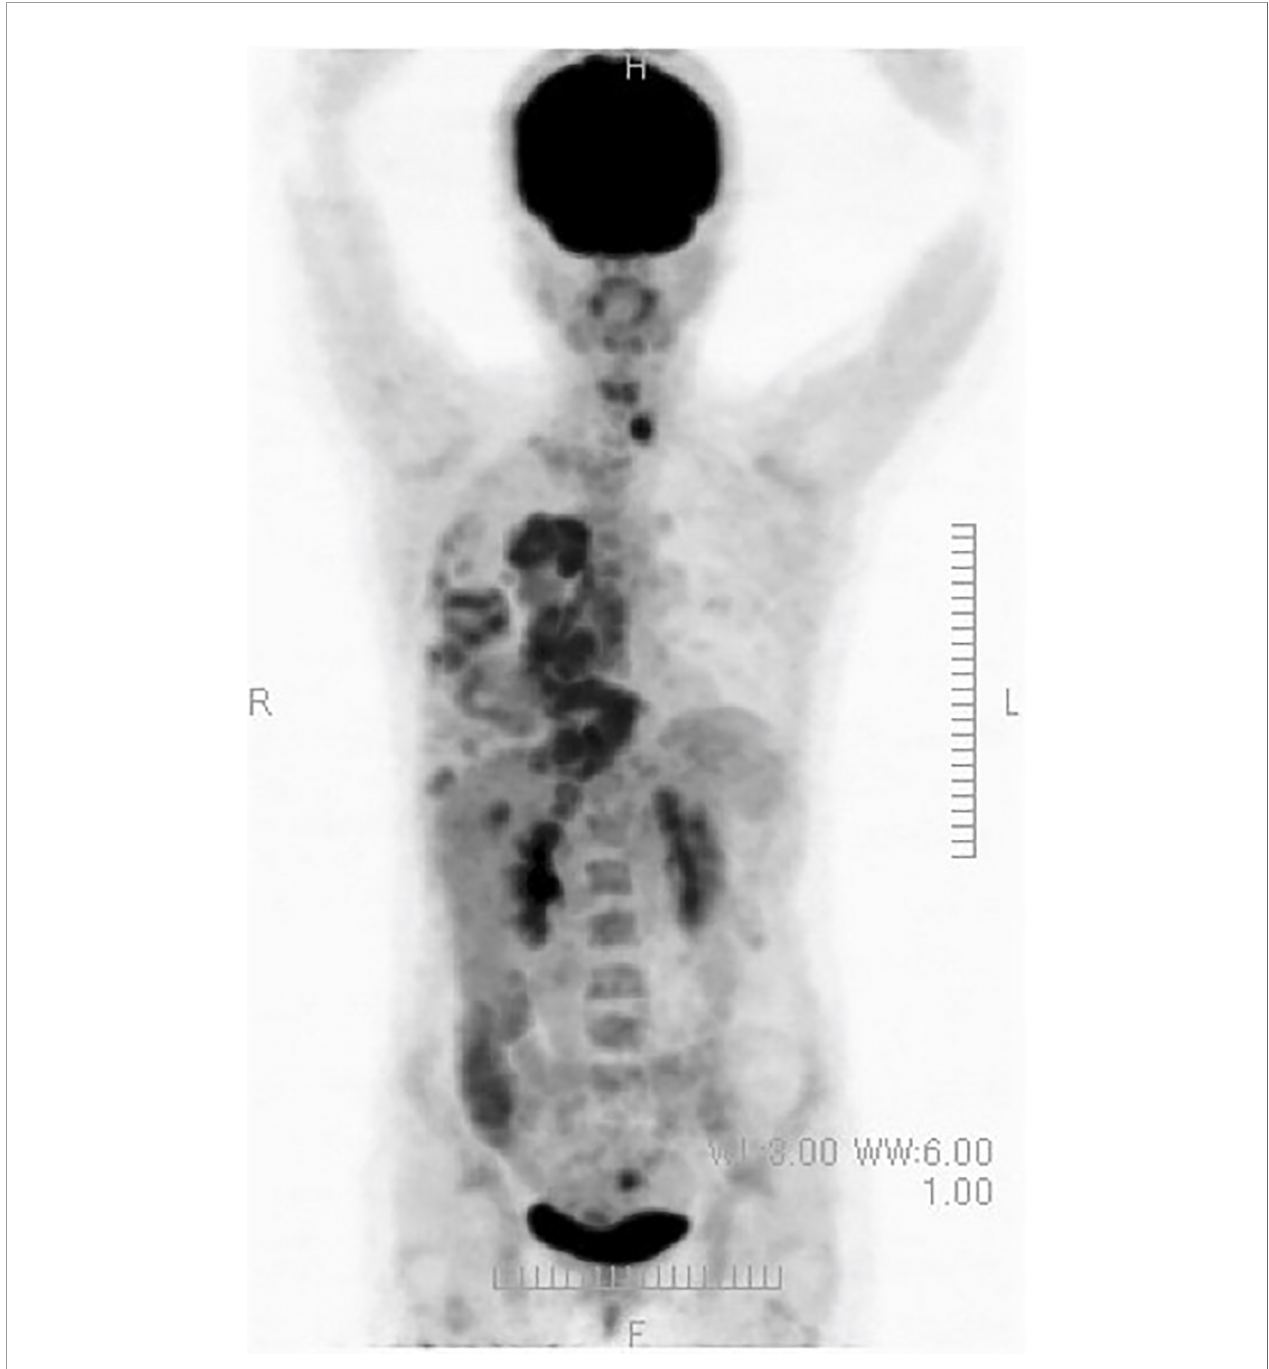
FIGURE 12 | A PET/CT scan shows abnormal accumulations on her